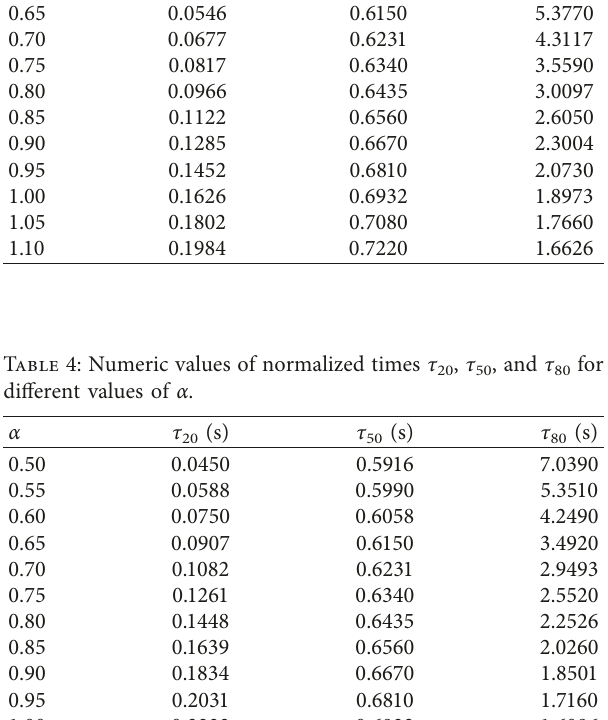
25 , τ 50 , and τ 75 for